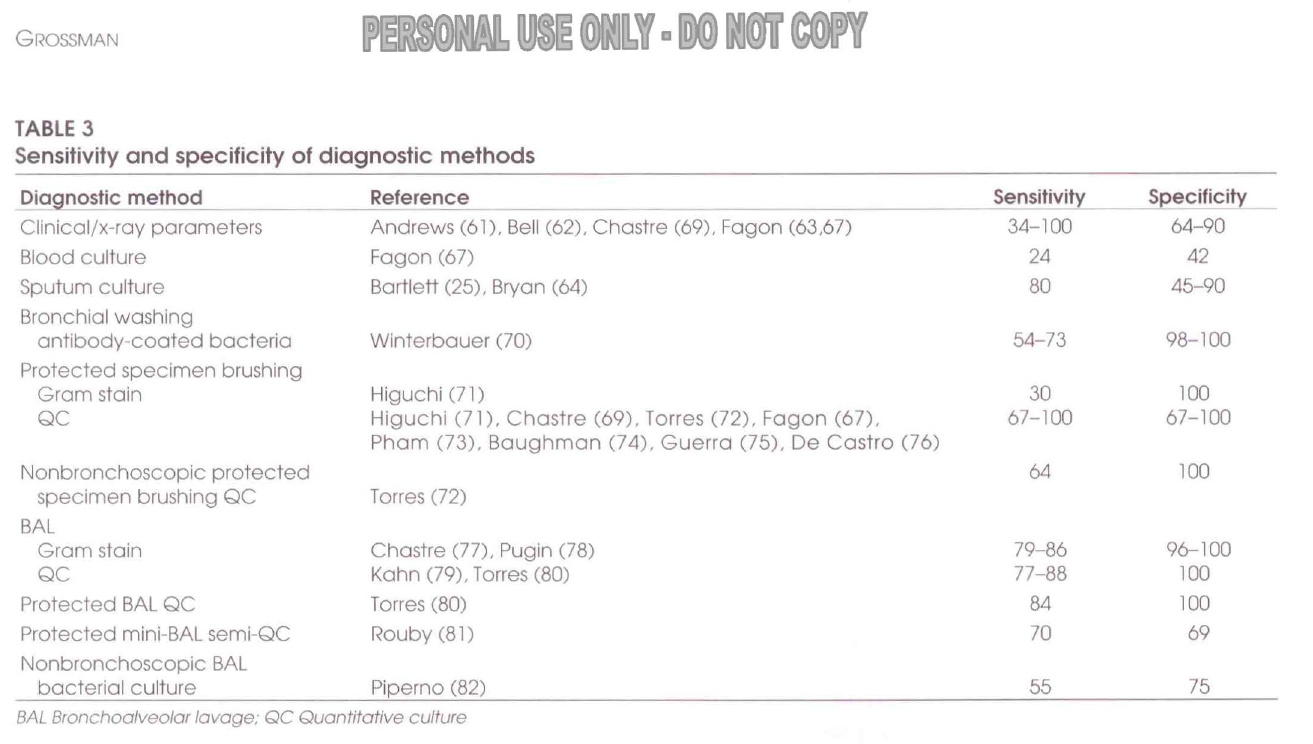
Sensitivity and specificity of diagnostic methods